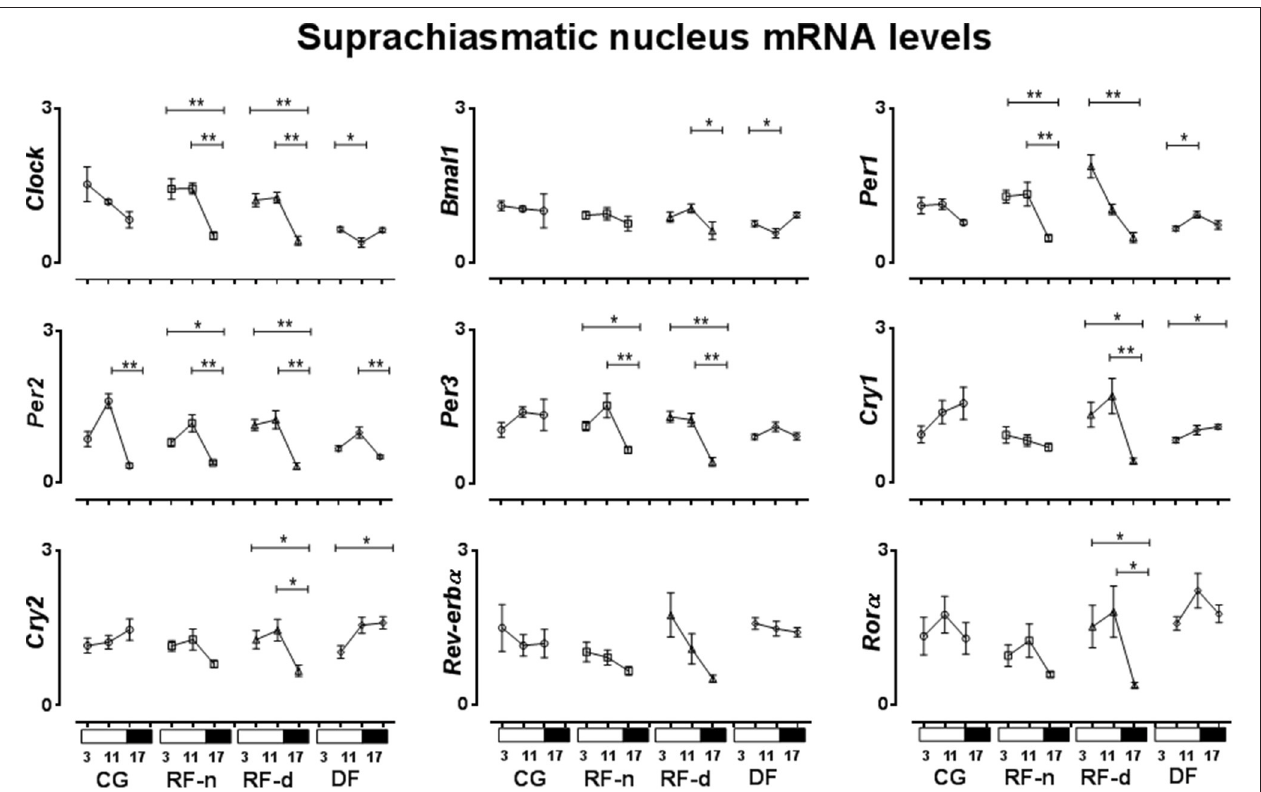
FIGURE 3 | Relative expression of clock genes in Suphrachiasmatic nucleus (SCN) in the control group, with food ad libitum ; restricted night-fed group (RF-night), with access to food restricted to ZT12–ZT14 (1800–2000h); restricted day-fed group (RF-day), with access to food restricted to ZT3–ZT5 (0900–1100h); and day-fed group (DF), with access to food restricted to ZT0–ZT12 (0600–1800h) at ZT3, ZT11, and ZT17, corresponding to 0900, 1700, and 2300h; respectively. N = 6–10 rats per time point per group. ZT, Zeitgeber Time. Significant difference among ZTs within the same feeding condition: * P < 0.05, ** P <